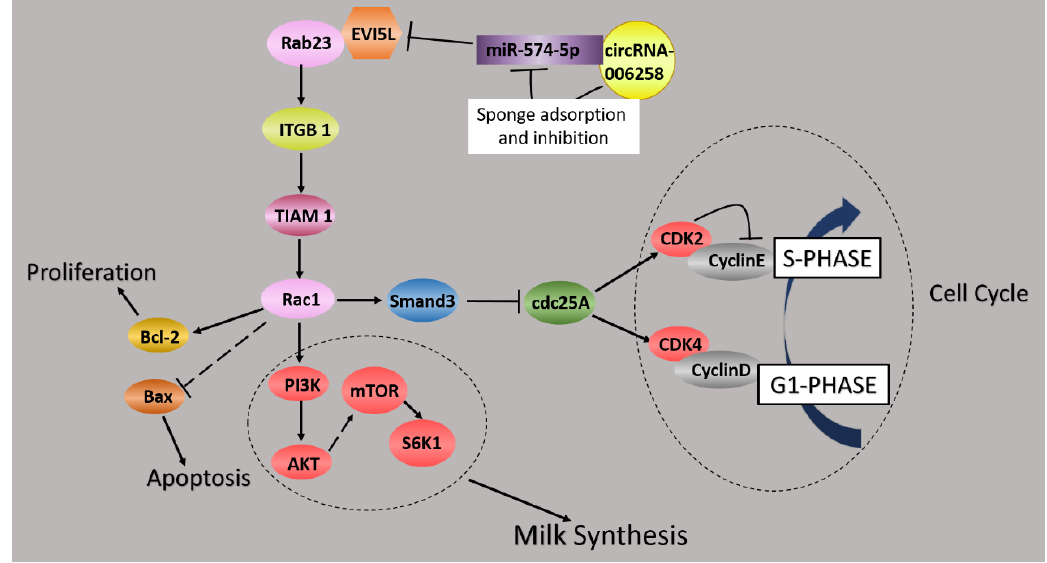
Figure 8. circ-006258/miR-574-5p/ EVI5L regulates cell growth and the milk synthesis in GMECs. Supplementary Materials: The following are available online at www.mdpi.com/xxx/s1, Figure S1: EVI5L and circ-006258 promoted GMEC proliferation in GMECs, Table S1: The validated primers used for psiCHECK-2 vectors, Table S2: EVI5L, circRNA-006258 and miR-574-5p sequences.